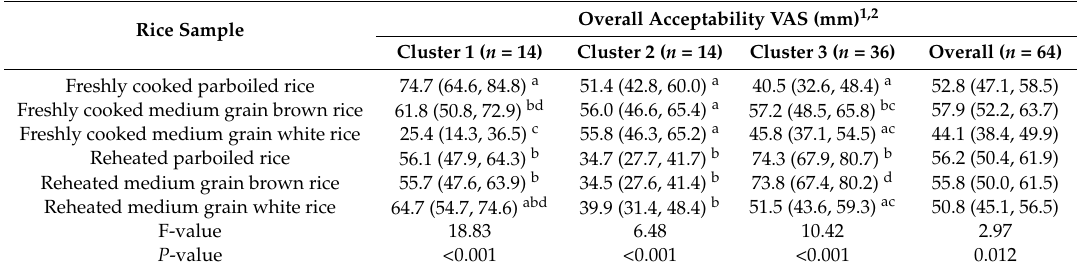
Table 3. Mean Visual Analogue Scales (VAS) score (mean, 95% confidence intervals) of overall acceptability scores for each cluster, including overall mean